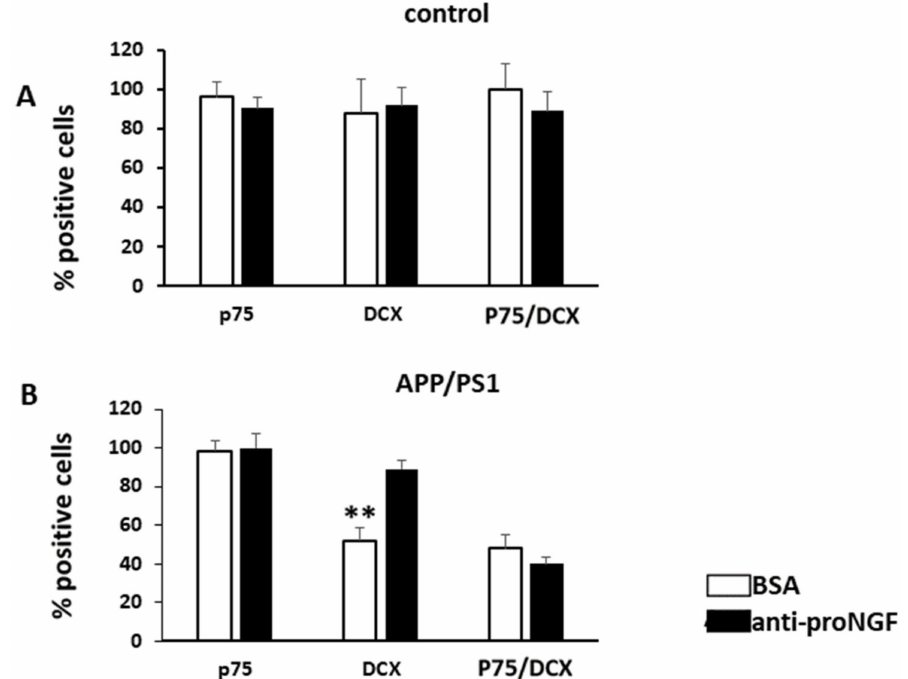
Figure 6. APP/PS1 animals show an increase in DCX positive cells after the injection of the anti- proNGF antibody. Comparison of BSA and anti-proNGF antibody injected into control mice ( A ) or into APP/PS1 mice ( B ). Quantification is refereed to Figure 5. Values are expressed as the percentage of the highest mean. ( n = 5 mice per group). p ≤ 0.01